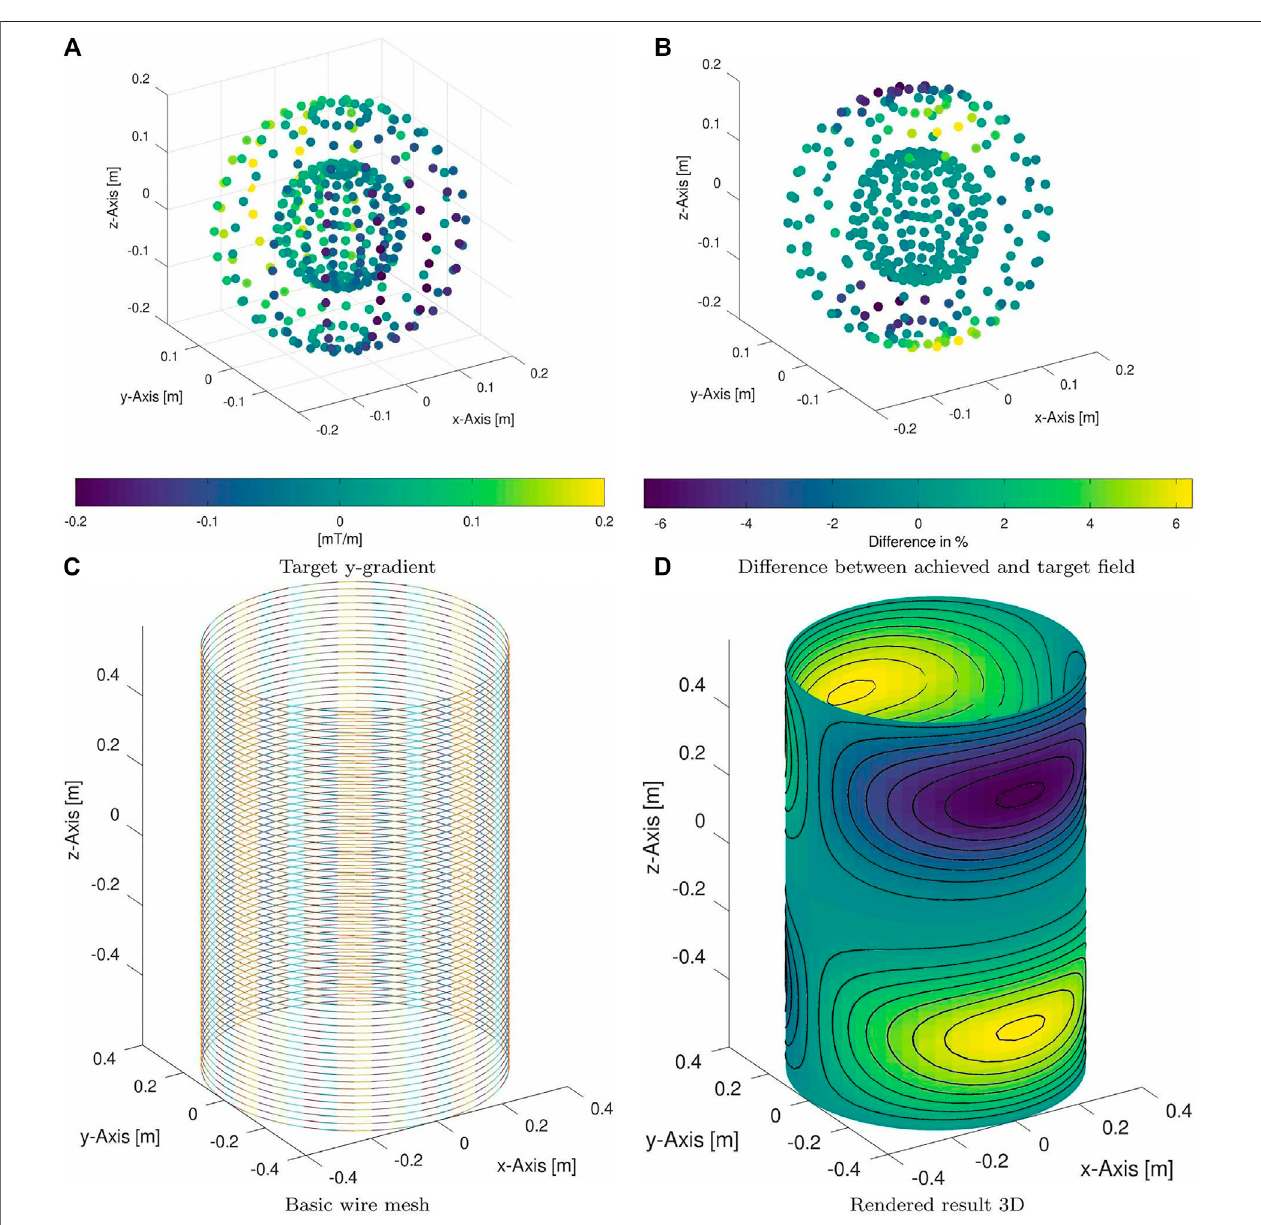
FIGURE 3 | (A) A spherical y-gradient target with 1 [ mT / m ] was used for the cylindrical coil design. (B) The difference between target and generated fi eld is depicted. (C) Themeshfortheoptimizationconsistsofsingleindividualwireswhichareorientedorthogonaltothemain fi elddirection. (D) 3D-renderingwithdimensions of the resulting cylindrical whole-body gradient